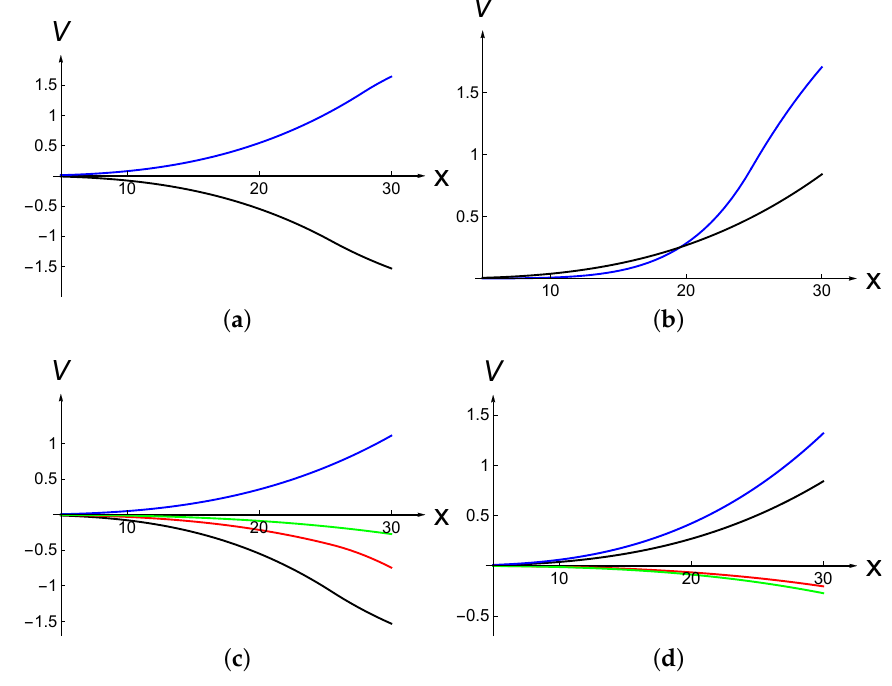
Figure 6. The values of delayed jump premium (DJP) and early investment premium (EIP) and their components w.r.t. x . The parameter set is r = δ = 0.03, σ = 0.3, K 1 = 10, K 2 = K 1 ( 1 + γ ) , γ = ± 0.2, λ = 0.2. ( a ) upper-left: the value of DJP V ( x ) − V 2 ( x ) when γ = 0.2 (blue) and γ = − 0.2 (black); ( b ) upper-right: the value of EIP V ( x ) − V w ( x ) when γ = 0.2 (blue) and γ = − 0.2 (black); ( c ) lower-left: components of DJP (black line) when γ = − 0.2: the net benefit (blue line) δ X − rK 1 collected by optimally investing prior to the jump, the net cost (red line) δ X − rK 2 incurred by foregoing optimal investment at K 2 and the expected jump cost (green line) λ ( K 1 − K 2 ) associated with investment at the higher K 1 ; ( d ) lower-right: components of EIP (black line) when γ = − 0.2— instantaneous dividends δ X collected (blue), interest loss on the strike rK 1 (red), loss associated with expected jump in the strike λ ( K 1 − K 2 )